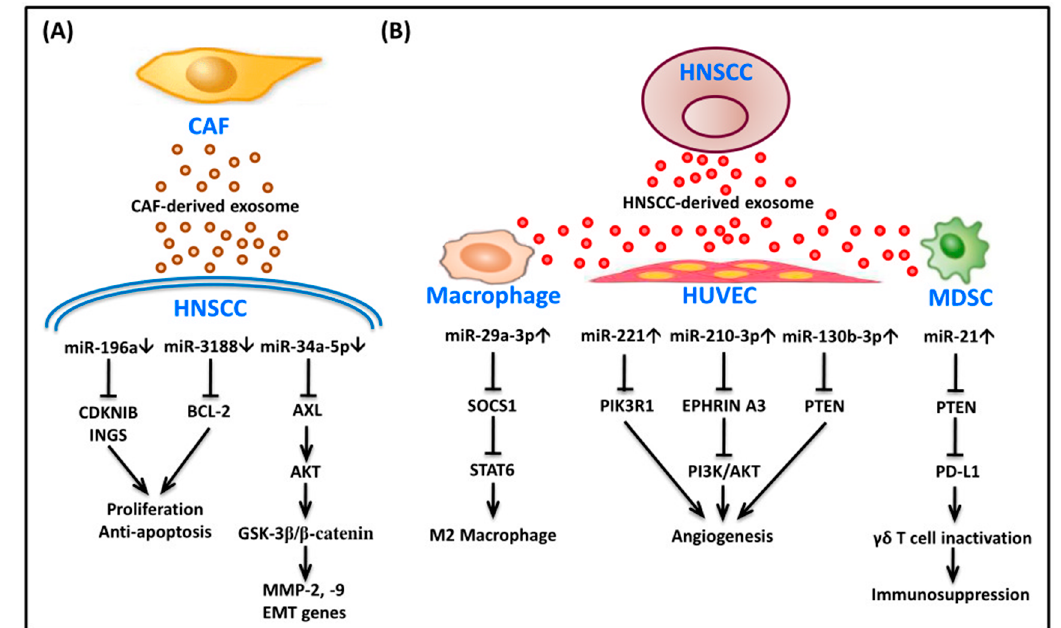
Figure 1. Summary of exosomal miRNAs and their key targets, including the associated signaling pathways involved in the HNSCC TME. ( A ) Exosomal miRNAs interact between CAF and HNSCC. The expression level of miR-196a, miR-3188, and miR-34a-5p in CAF-derived exosomes has been found to be significantly lower than that of NF-derived exosomes. These down-regulated miRNAs in CAF-derived exosomes modulate the migration, EMT, and anti-apoptosis, as well as tumor growth. ( B ) Exosomal miRNAs interact between HNSCC and HUVEC, and macrophage and MDSC. The differential expression of miRNAs in HNSCC-derived exosomes modulate the M2 polarization of microphage, the angiogenesis of HUVEC, and immunosuppression of MDSC in HNSCC TME. Abbreviations: BCL2, B-cell lymphoma 2; CAF, cancer-associated fibroblast; CDKN1B, cyclin dependent kinase inhibitor 1B; EMT, epithelial-mesenchymal transition; GSK-3 β , Glycogen Synthase Kinase 3 β ; HNSCC, head and neck squamous cell carcinoma; HUVEC, human umbilical vein endothelial cell; ING5, inhibitor of growth family member 5; MDSC, myeloid-derived suppressor cell; MMP, matrix metallopeptidase; PD-L1, programmed death receptor ligand 1; PI3K, phosphoinositide 3-kinase; PIK3R1, phosphoinositide 3-kinase regulatory subunit 1; PTEN, phosphatase and tensin homolog deleted on chromosome 10; SOCS1, suppressor of cytokine signaling 1; STAT6, signal transduction and transcriptional activator 6; TME, tumor microenvironment.